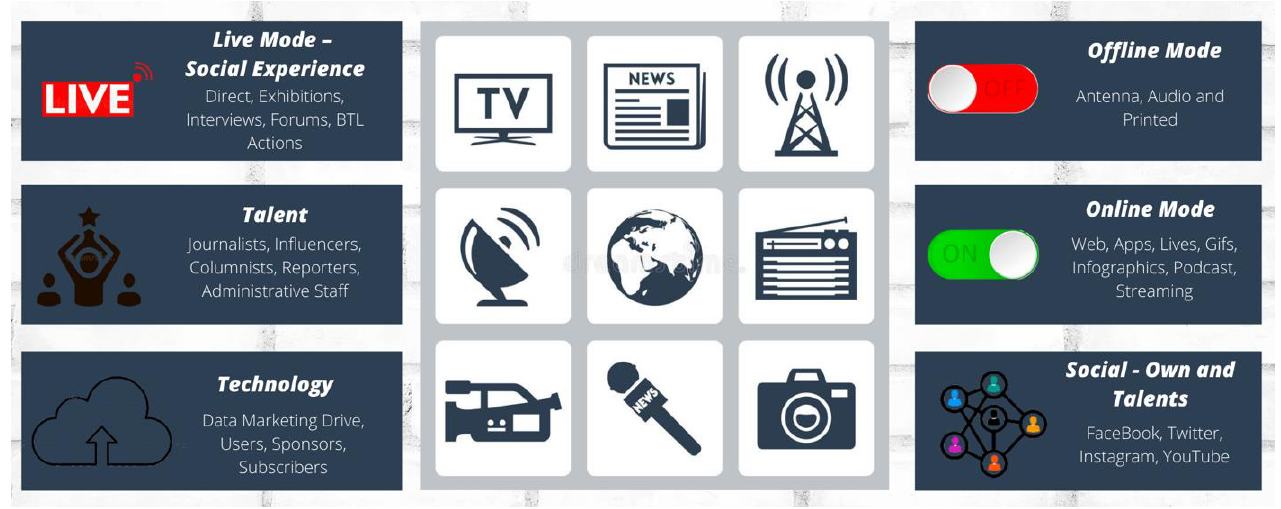
Figure 8. Convergence of approaches to the media content. Prepared by author.